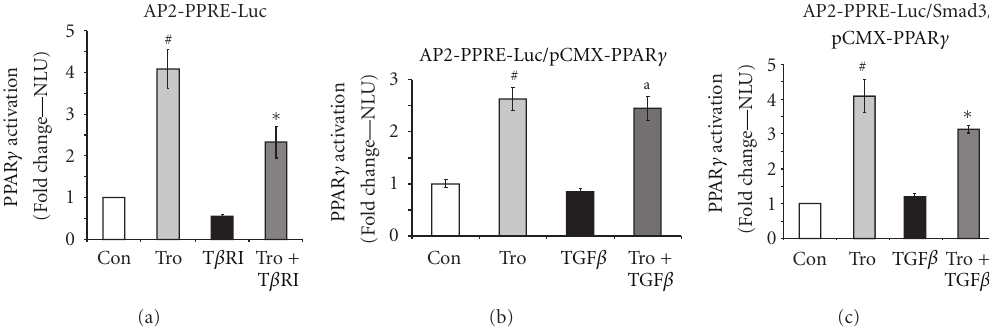
Figure 3: TGF β 1 signaling inhibits the transcriptional activity of PPAR γ . PPAR γ transcriptional activity was determined with luciferase assays in NIH/3T3 fibroblasts bearing a PPAR γ response element-luciferase reporter (AP2-PPRE-Luc). Luciferase activity was normalized to Renilla with data shown as fold change ± SE relative to control. # P < 0 . 001 compared to control. ∗ P < 0 . 001 compared to troglitazone. a P : ns compared to troglitazone. (a) E ff ects of troglitazone and TGF β RI. PPRE-containing NIH/3T3 fibroblasts were treated with troglitazone (Tro 10 μ M) and/or cotransfected with a constitutively active type I TGF β receptor (TGF β RI). At 24 hours, cells were analyzed for luciferase activity. (b) Overexpression of PPAR γ gene. The full-length PPAR γ gene and a PPRE were cotransfected into NIH/3T3 fibroblasts, which were then pretreated with TGF β 1 (10 ng/mL) for 1 hour, followed by troglitazone (10 μ M) for 24 hours. (c) Role of Smad3. Smad3 and PPAR γ were coexpressed in NIH3T3 fibroblasts with a PPRE. Cells were exposed to TGF β 1 (10ng/mL) for 1 hour and then stimulated with troglitazone (10 μ M) for 24